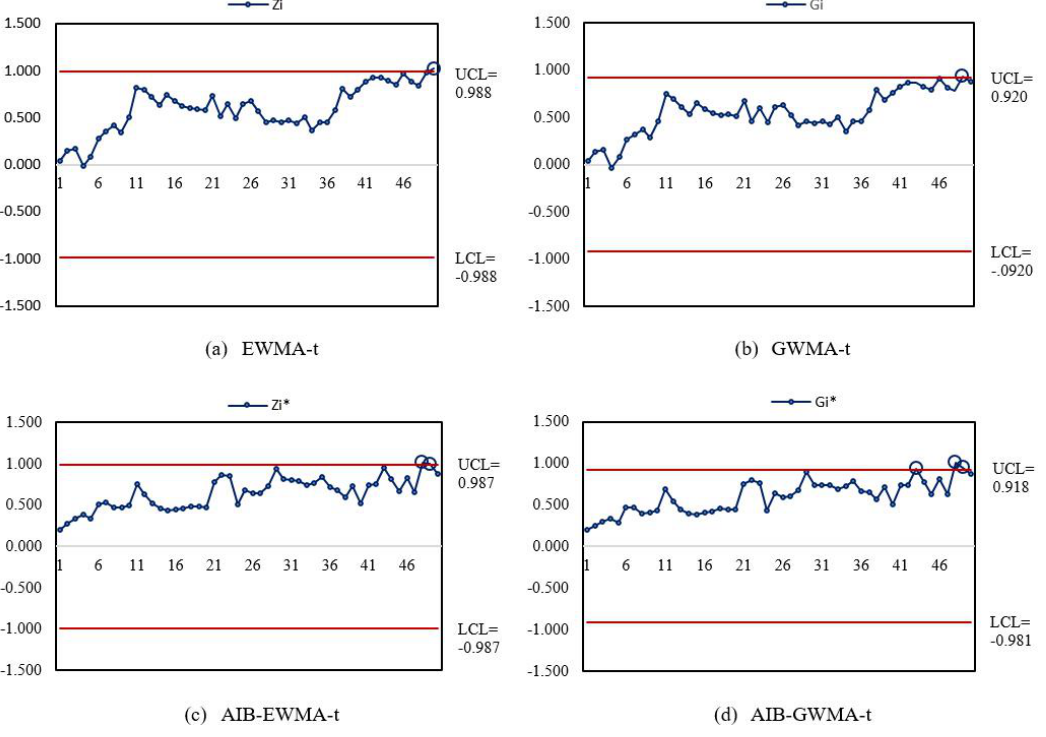
Figure 3. The statistics and control limits of the AIB-GWMA-t chart and its reduced types at ρ = 0.75 and δ = 0.2 .